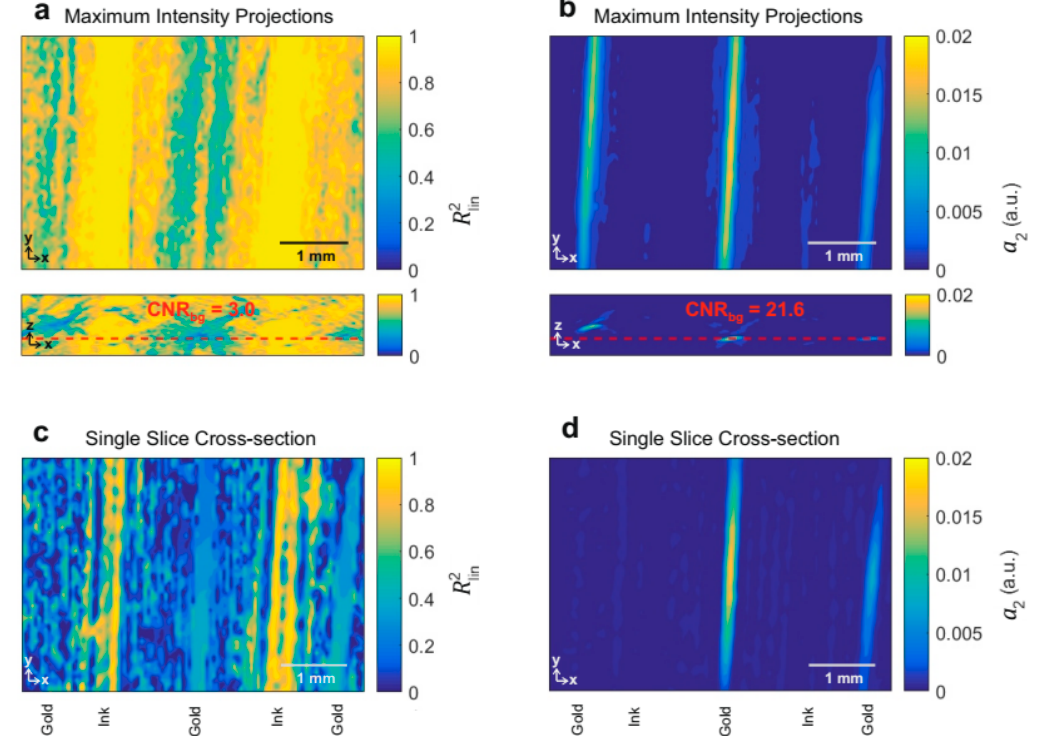
Figure 6. Results of Method I and II when omitting the image segmentation step. The 3D images are displayed as xy- and xz-MIPs showing ( a ) R 2 from Method I (linear regression) and ( b ) a 2 from Method II (polynomial fit). Contrast-to-background-noise ratios (CNR bg ) are also reported. A dotted red line shows the z -plane of the xy cross-sectional images shown in ( c ) for R 2 from Method I and ( d ) a 2 from Method II.